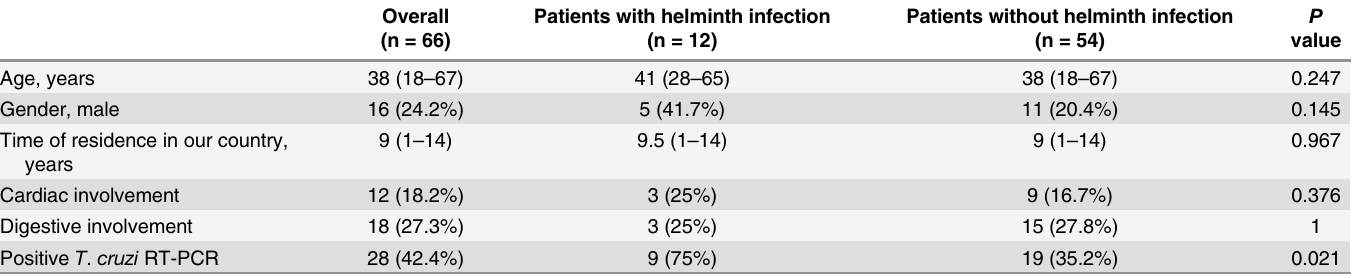
Table 2. Main clinical and epidemiological characteristics of Chagas disease patients visited at Vall d ’ Hebron University Hospital from March 2014 to February